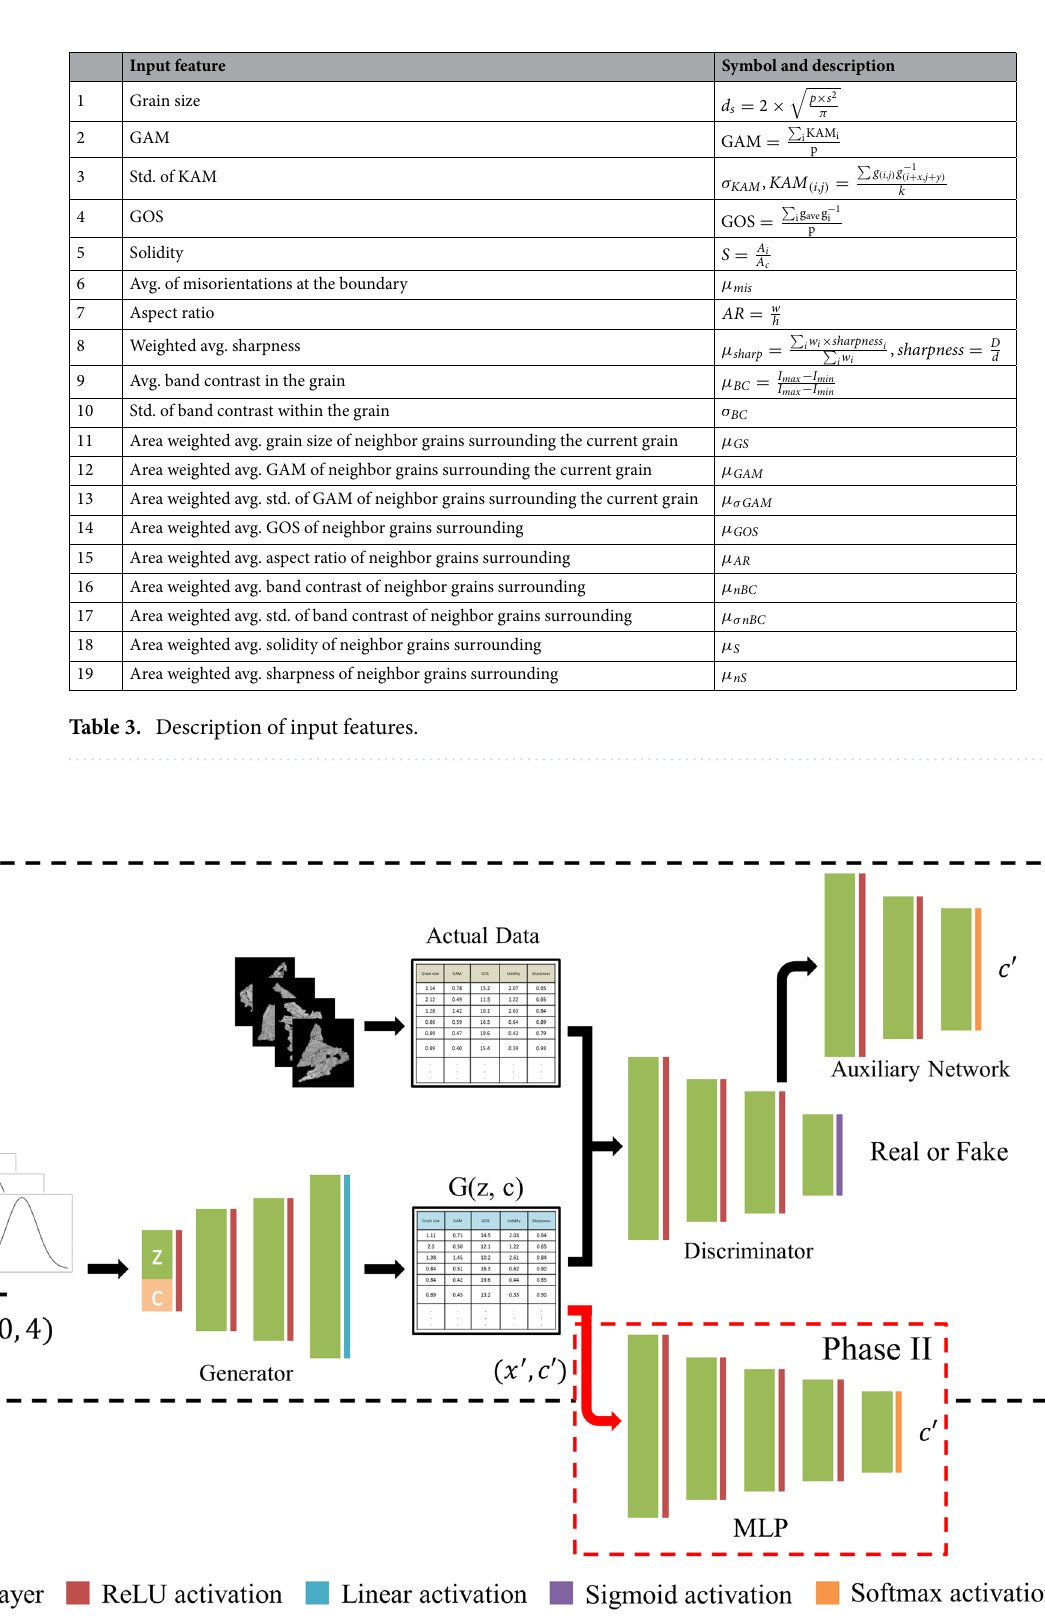
Figure 5. InfoGAN and MLP classifier structures are shown inside dashed black and red boxes, respectively. In Phase I, InfoGAN is trained. In Phase II, the generator creates samples and labels ( x to MLP for training. Then, the trained model performs the classification of raw